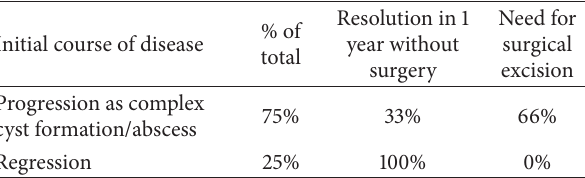
Table 2: Follow-up of imaging findings.